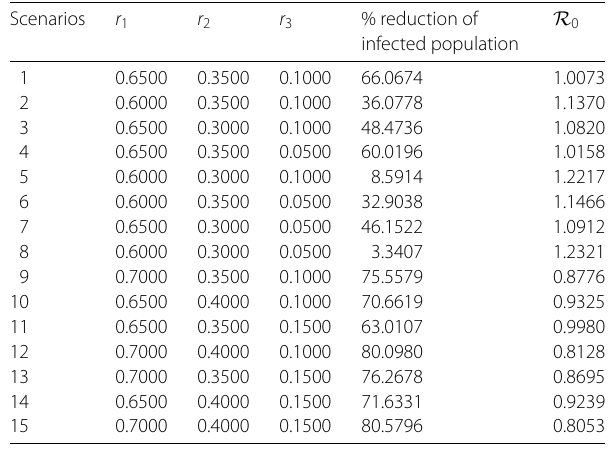
Table 5 Impact of WatSan services on the percentage reduction in the infected population